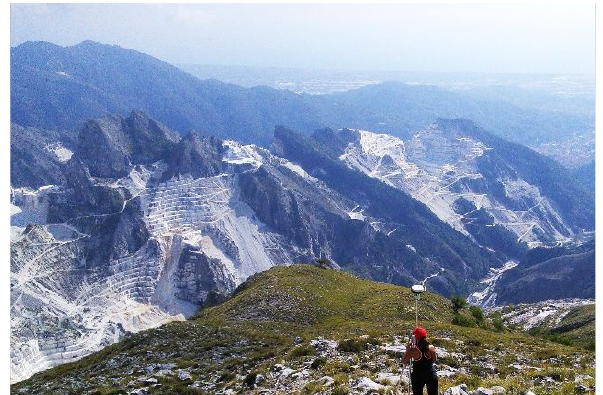
Figure 1. Panoramic view from the top of the Torano Basin; from the highest point to the main access road, the altitude difference is about 1,000